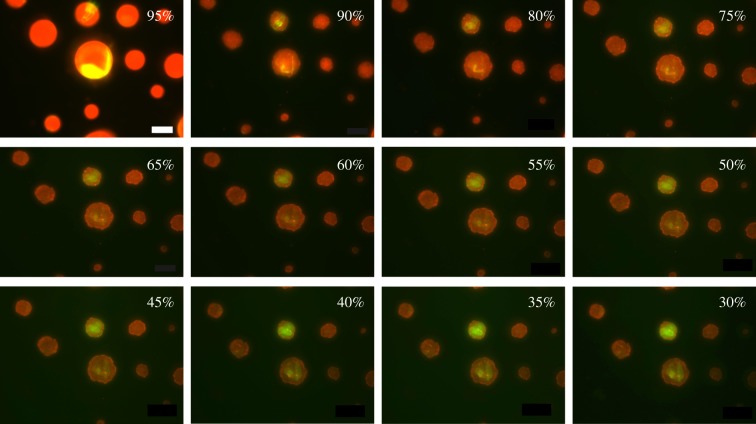
Fluorescence images of droplets exposed to decreasing RH. Droplets were aerosolized from a solution containing NaCl, mucin and DPPC in water. The red and green colours indicate mucin and DPPC, respectively. Droplets were initially exposed at 100% RH, and then the RH was ramped down at 5%/min. Droplets exposed at near-100% RH appeared similar to those at 95%. Scale bar represents 20 µm.